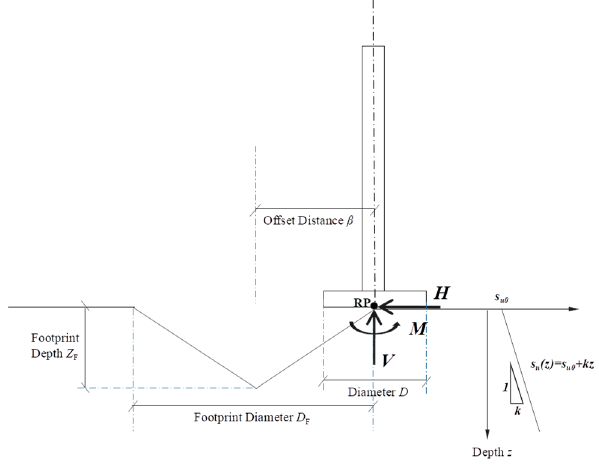
Figure 3. Sign convention and definition of terminology.